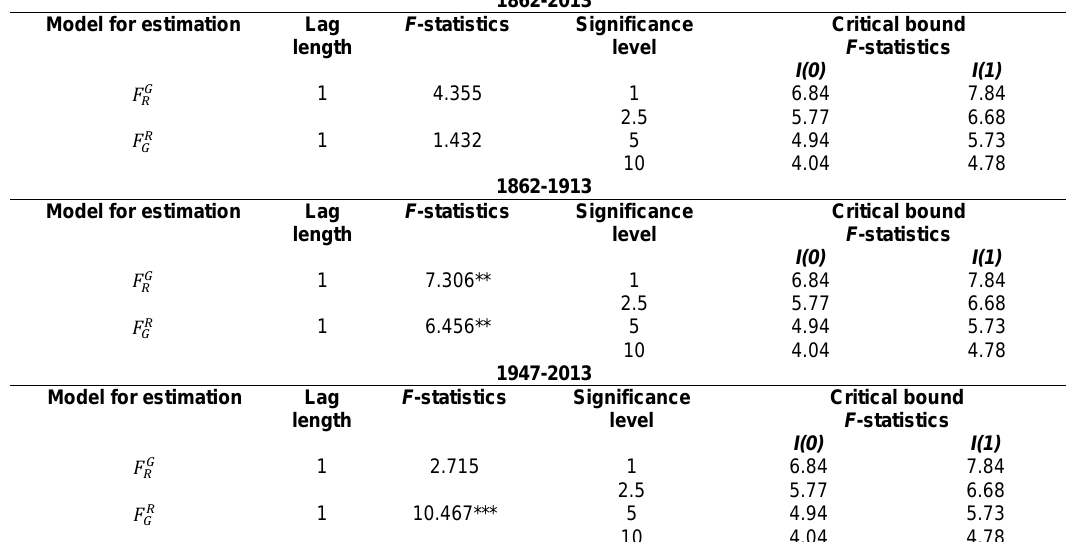
Table 4 . ARDL bounds test estimation